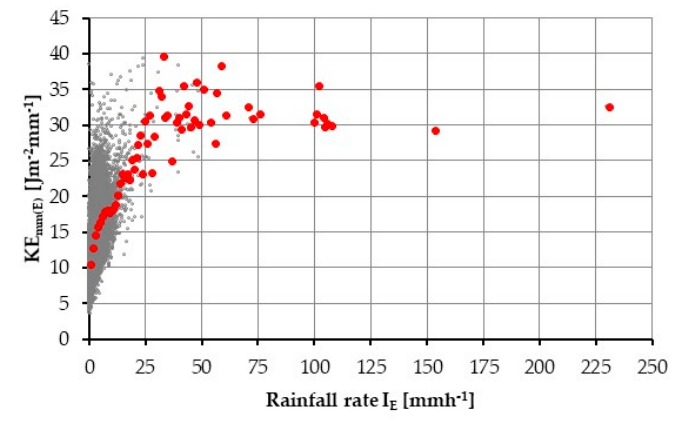
Figure 12. Relationship between the empirical values of the kinetic energy content and rainfall intensity for single (grey dots) and aggregated (red dots) DSDs.